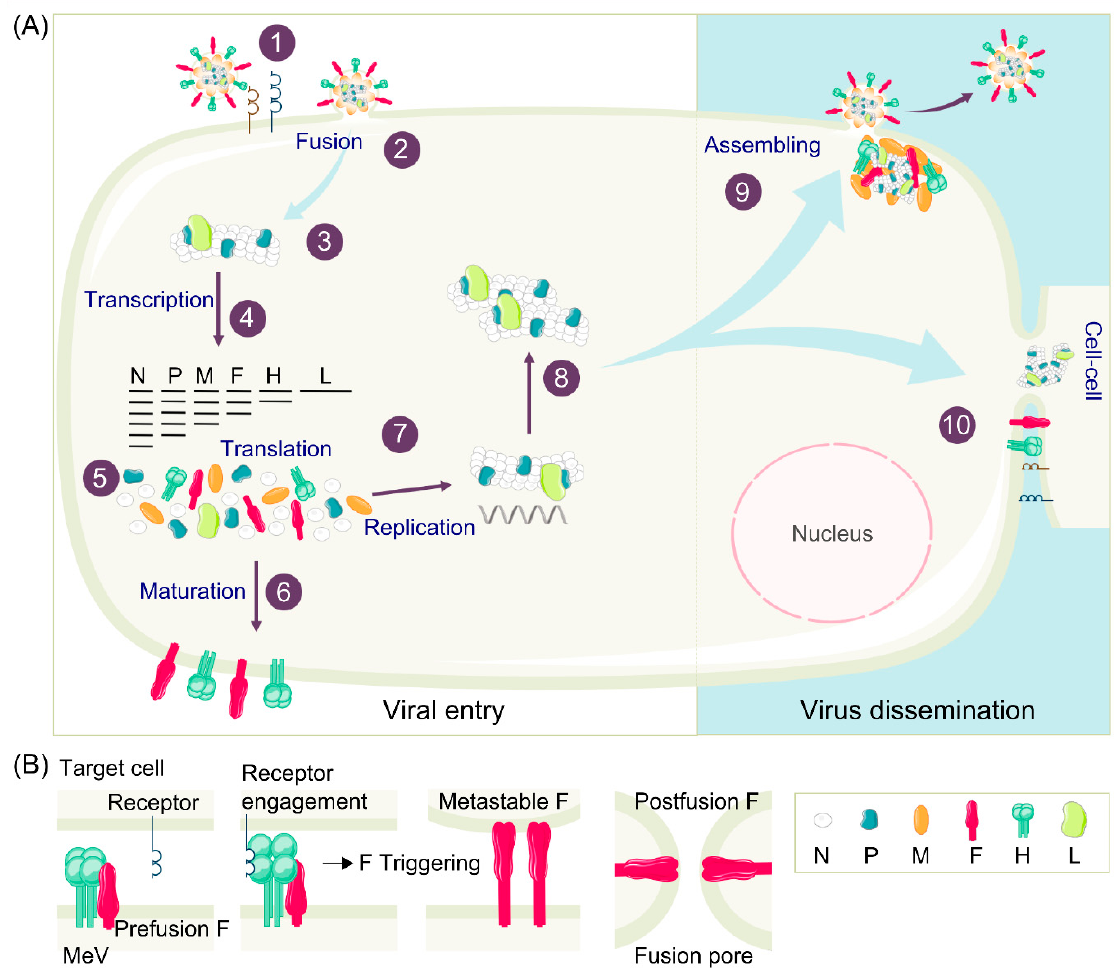
Figure 1. Measles Virus (MeV) replication cycle. ( A ) In order to infect a susceptible and permissive cell, MeV binds to its entry receptors on the cell surface (1) and initiates the virus-cell membrane fusion (2), as described in detail in ( B ). Virus and cell membranes fusion leads to genome delivery into the cytoplasm (3). Viral RNA is transcribed in mRNA (4) that is further translated into viral proteins (5). Viral glycoproteins maturate during their transport to the cell surface (6). The replication of positive stranded anti-genomic RNA starts in the cytoplasm (7) and serves as a template for synthesis of new negative stranded genomic RNA (8). Viral proteins assemble at the cell surface, leading either to budding of new virions (9) or cell-to-cell fusion (10). ( B ) The haemagglutinin (H) protein binds to the MeV receptor at the cell surface, allowing the triggering of fusion (F) which reaches a metastable conformation. Then, F protein anchors its fusion peptide in the target cell membrane, F undergoes serial conformational changes bringing the two membranes close enough to merge and form a pore throughout which the viral ribonucleocapsid (RNP) is delivered to the cytoplasm. Based on bioinformatic tools the HRN domain encompasses residues 116 / 138 to residue 190 and the HRC domain is included between residues 438 and 488 / 489. The current crystal structure however shows the region between 438 and 458 as disorganized while a canonical heptad repeat is shown after residue 458